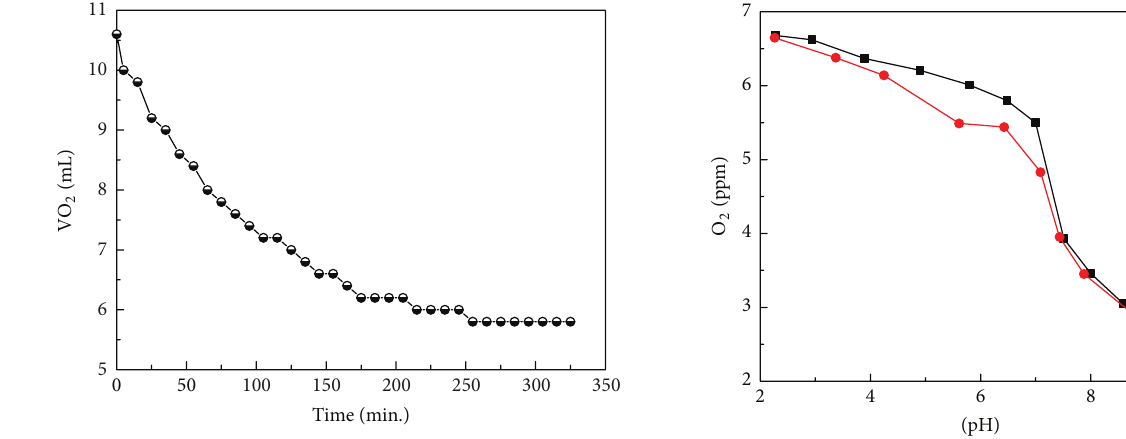
Figure 6: Absorbed volume of oxygen as determined by gas volumetric method.